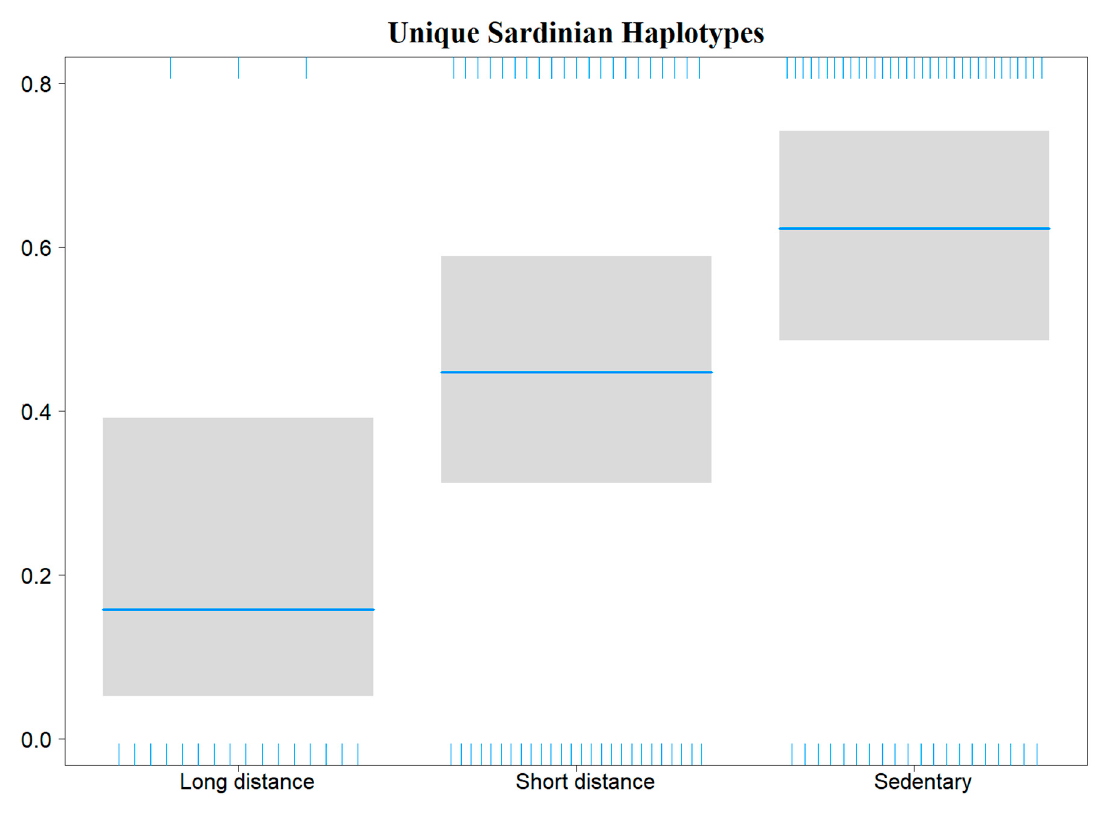
Figure 5. Plot showing the effects of species migratory patterns ( X axis) on the occurrence probability of novel haplotypes found in Sardinia ( Y axis) in those birds infected by